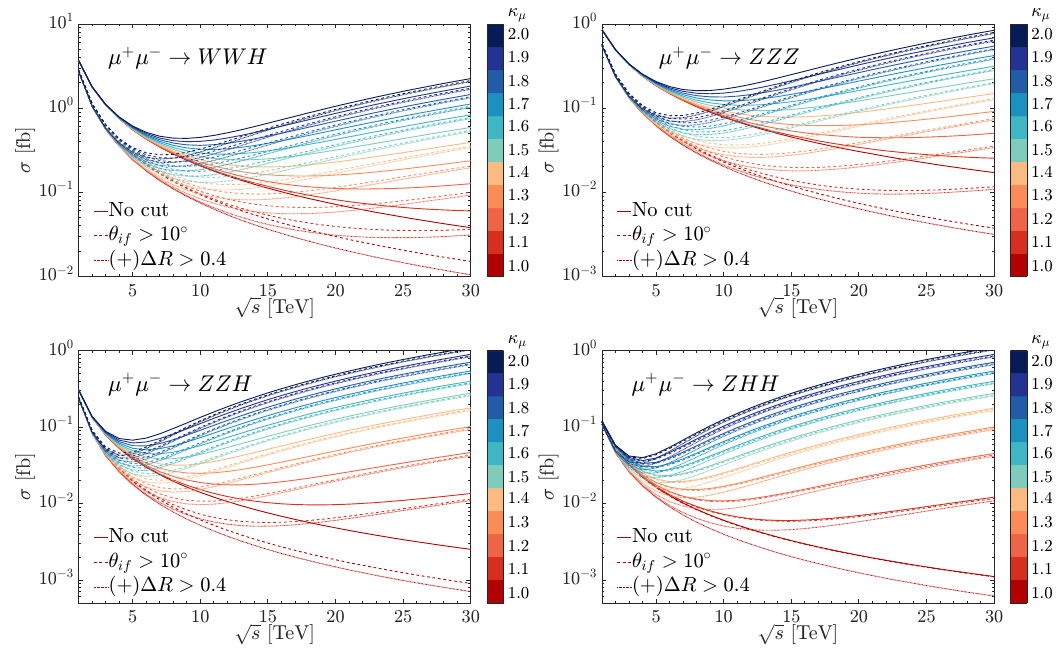
Figure 11 . The cross sections of annihilation without ISR for the three-boson production channels √ µ + µ − → WWH, ZZZ, ZZH, ZHH versus the µ + µ − c.m. energy s and the effective coupling κ µ . The lower two clusters of curves correspond the flow cut: θ if > 10 ◦ and the accumulated ∆ R > 0 . 4 . SM backgrounds ( κ = 1 ) if we assume the muon Yukawa coupling varying within a µ